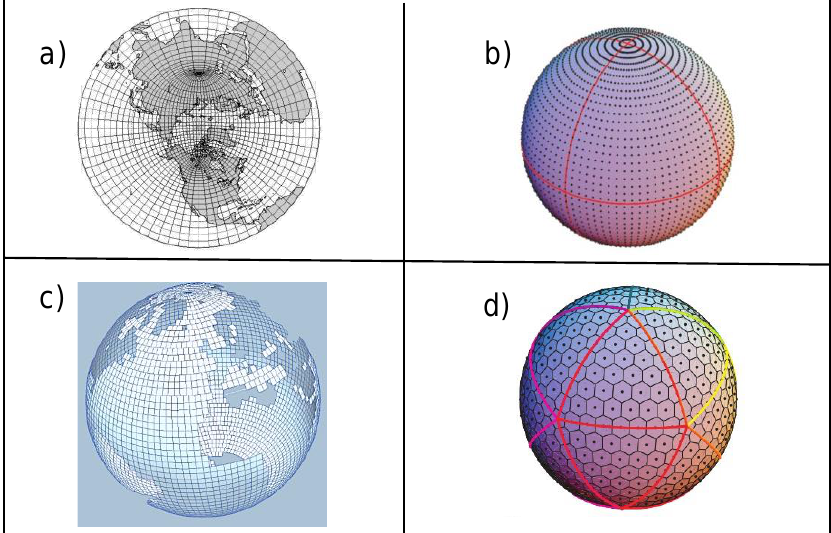
Figure 1. Illustration of the types of grids included in the benchmark: ( a ) rotated-stretched logically- rectangular ( torc, nogt ), ( b ) regular latitude–longitude ( bggd ), ( c ) Gaussian-reduced ( sse7 ), and ( d ) icosahedral ( icos, icoh ).